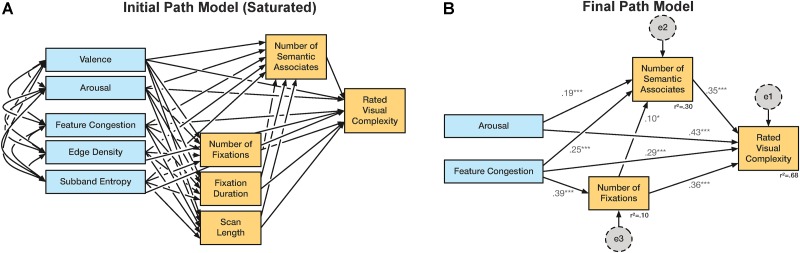
Path model used in Experiment 3. (A) Initial saturated path model. (B) Final path model. Variables shown in blue were coded as observed, exogenous variables; orange were observed, endogenous variables; gray were unobserved, exogenous variables (not shown in A). †p < 0.1; ∗p < 0.05; ∗∗p < 0.01; ∗∗∗p < 0.001.